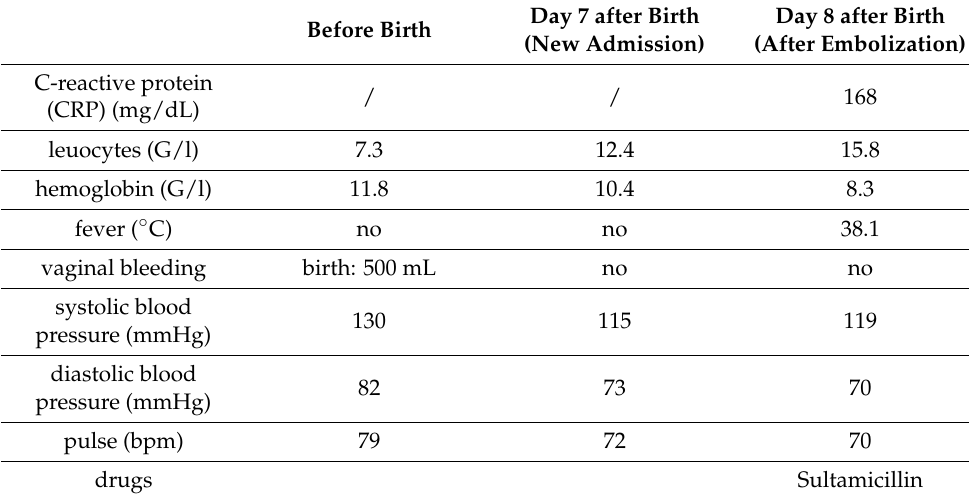
Figure 2. ( a ) Digital subtraction angiography (DSA) of the right hypogastric artery in 30° right anterior oblique projection demonstrating the large UAP (arrow). ( b ) Close-up of the UAP after superselective probing immediately before coiling (arrow). ( c ) DSA with total exclusion of the UAP after coil embolization (arrow). Table 1. Clinical and laboratory